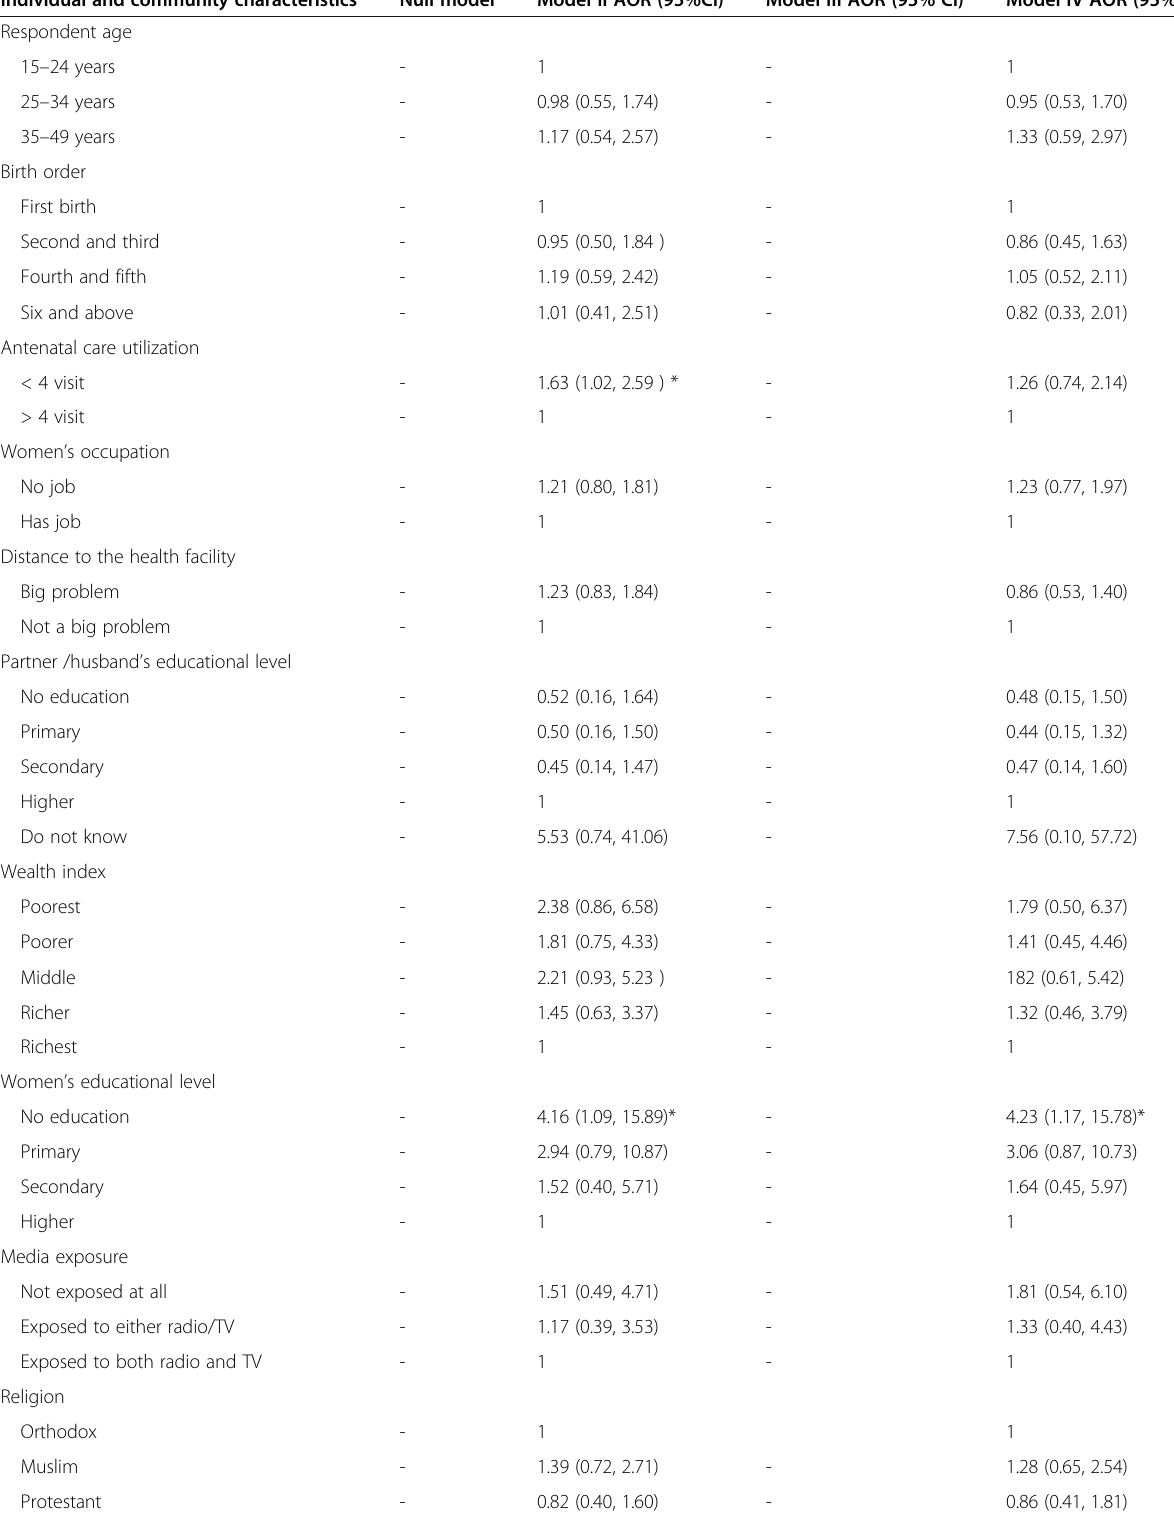
Table 4 Multilevel binary logistic regression analysis of individual- and community-level factors among children aged from 12 to 23 months in EDHS